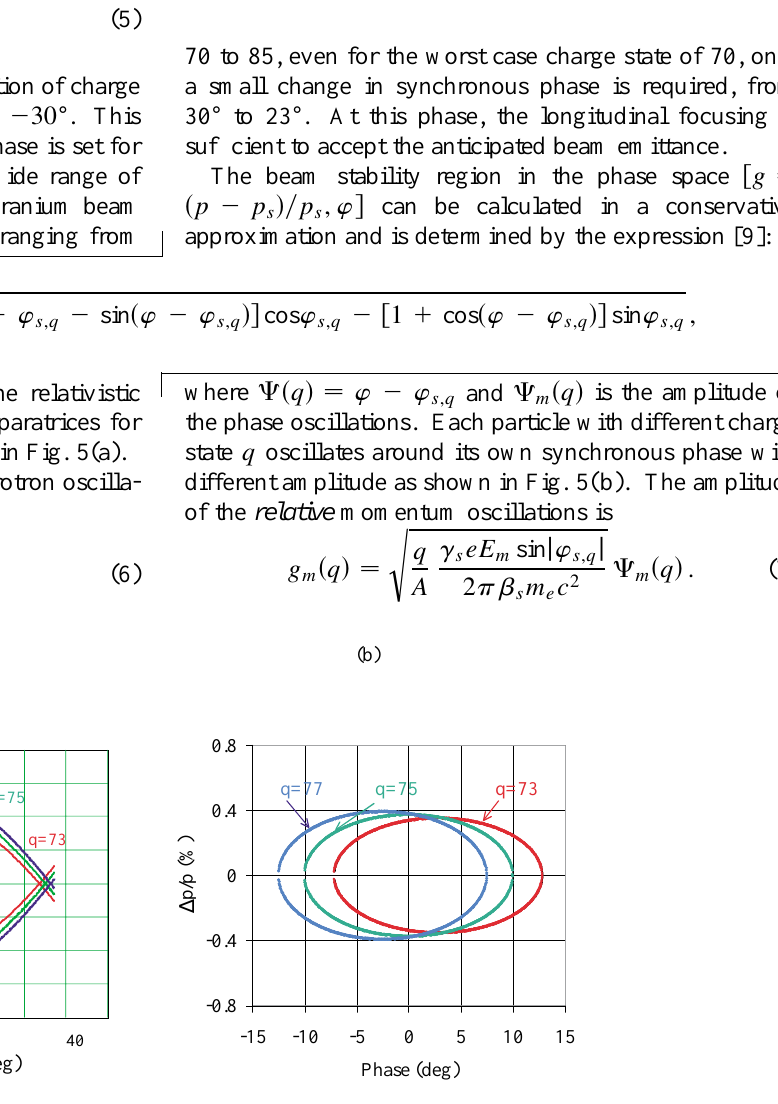
FIG. 4. (Color) Synchronous phase as a function of uranium ion charge state. The designed synchronous phase is 2 30 ± for q 0 (cid:1) 75 .